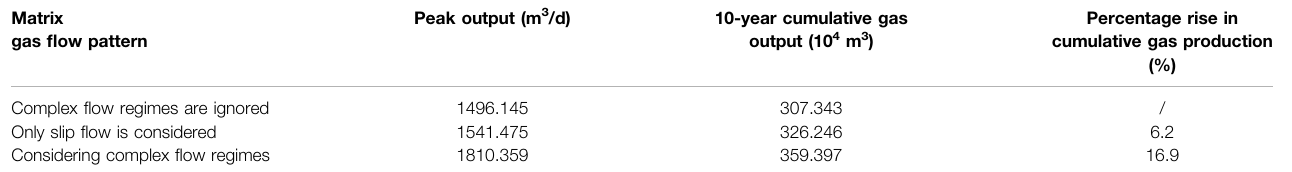
TABLE 4 | Effects on gas production when complex fl ow regimes are and are not considered.